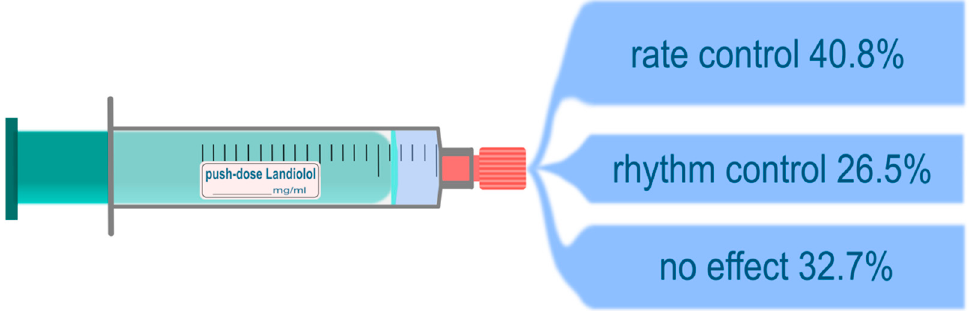
Figure 3. The performance of push-dose Landiolol in rate and rhythm control in the overall study cohort.